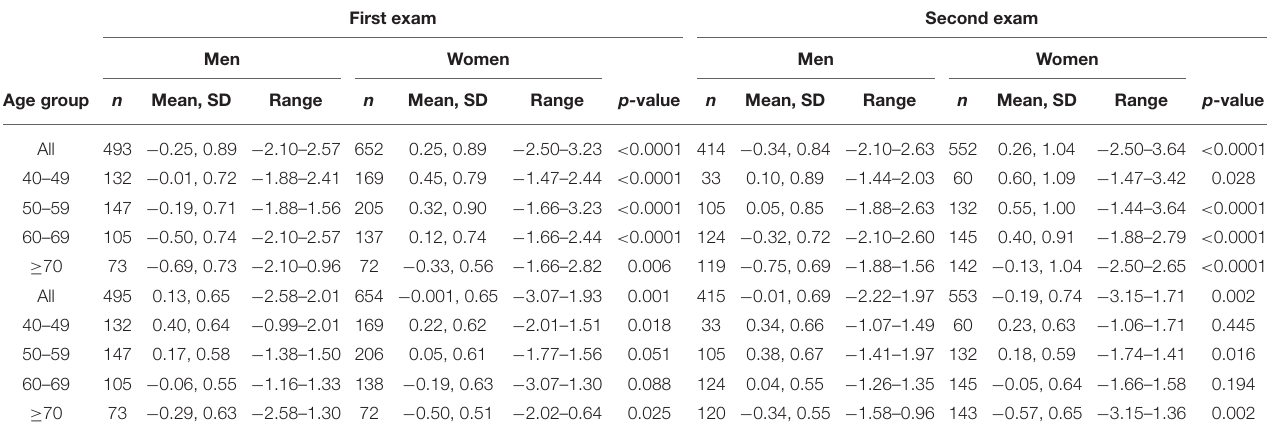
TABLE 1 | Means and standard deviations for EM and EF scores by gender at the two